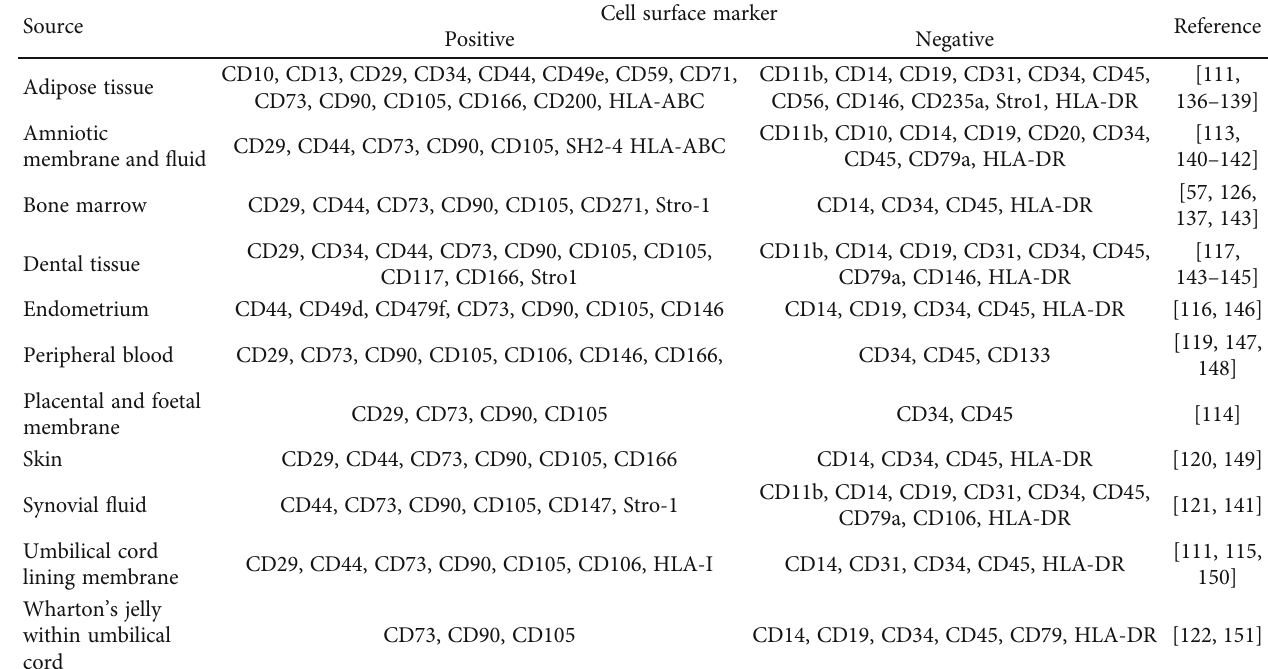
Table 1: Cell surface markers expressed by MSCs isolated from di ff erent